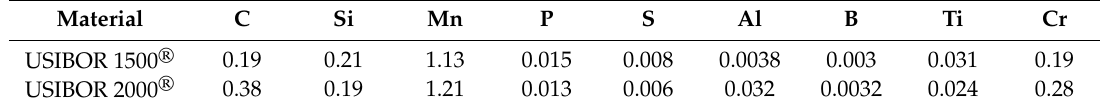
Table 1. Chemical compositions of the two steels (wt